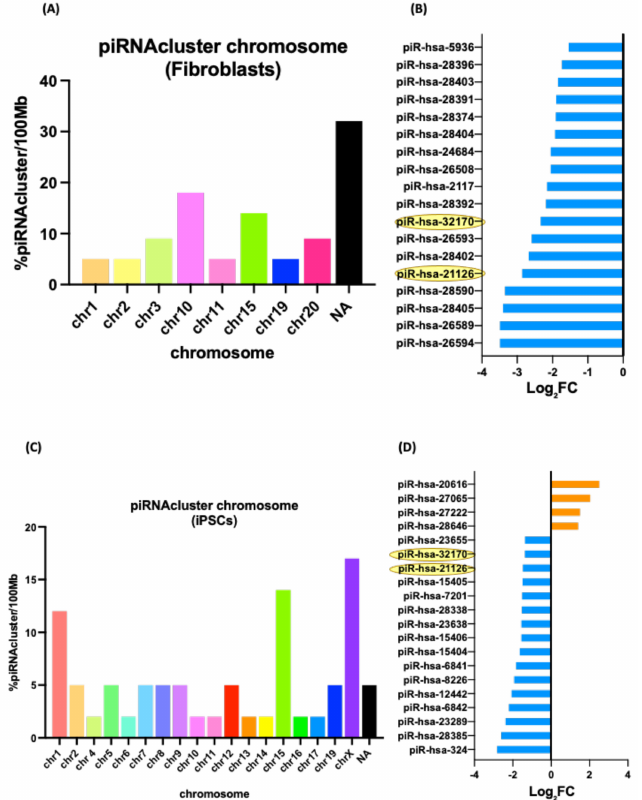
Figure 6. Distribution of piRNA clusters across chromosomes and differentially expressed (DE) piRNAs ( A ) piRNA cluster chromosome in fibroblasts with higher reprogramming efficiency. ( B ) DE piRNA in fibroblasts with higher reprogramming efficiency. ( C ) piRNA cluster chro- mosome in iPSCs with higher reprogramming efficiency. ( D ) DE piRNA in iPSCs with higher reprogramming efficiency. Table 1. piRNA downregulated in fibroblasts that showed higher efficiency in reprogramming.